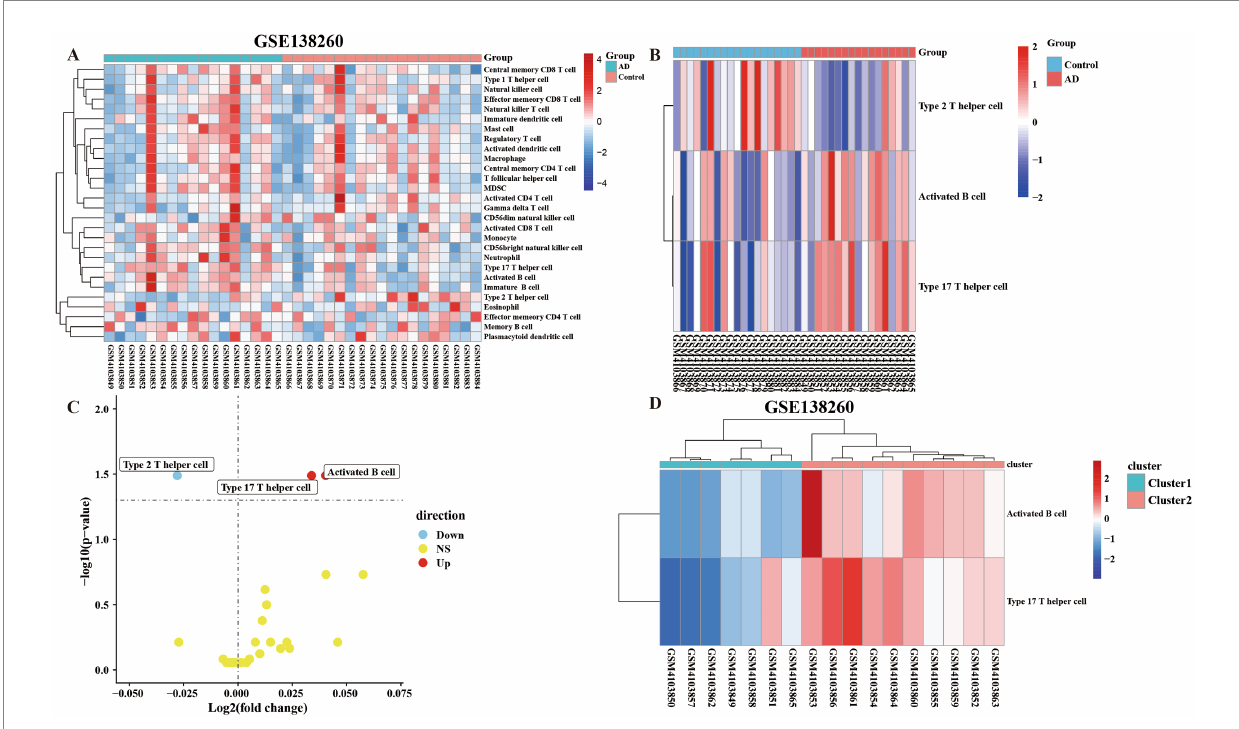
FIGURE 2 The ssGSEA algorithm was used to assess the immune infiltration of 28 immune cells in 36 samples. (A) The 28 kinds of immune cells were divided into the control group and the AD group for all heatmap analysis of the difference of cellular immune infiltration degree. (B) Immune heatmap for differential analysis of immune infiltration by dividing AD group and control group (FC > 1 and p < 0.05). (C) Volcano plot of differentially analyzed cells classified into two clusters by differential analysis of immune infiltration. (D) Heatmap of the cells screened by the differential analysis of immune infiltration in the AD group were classified into two clusters and subjected to subtype GO